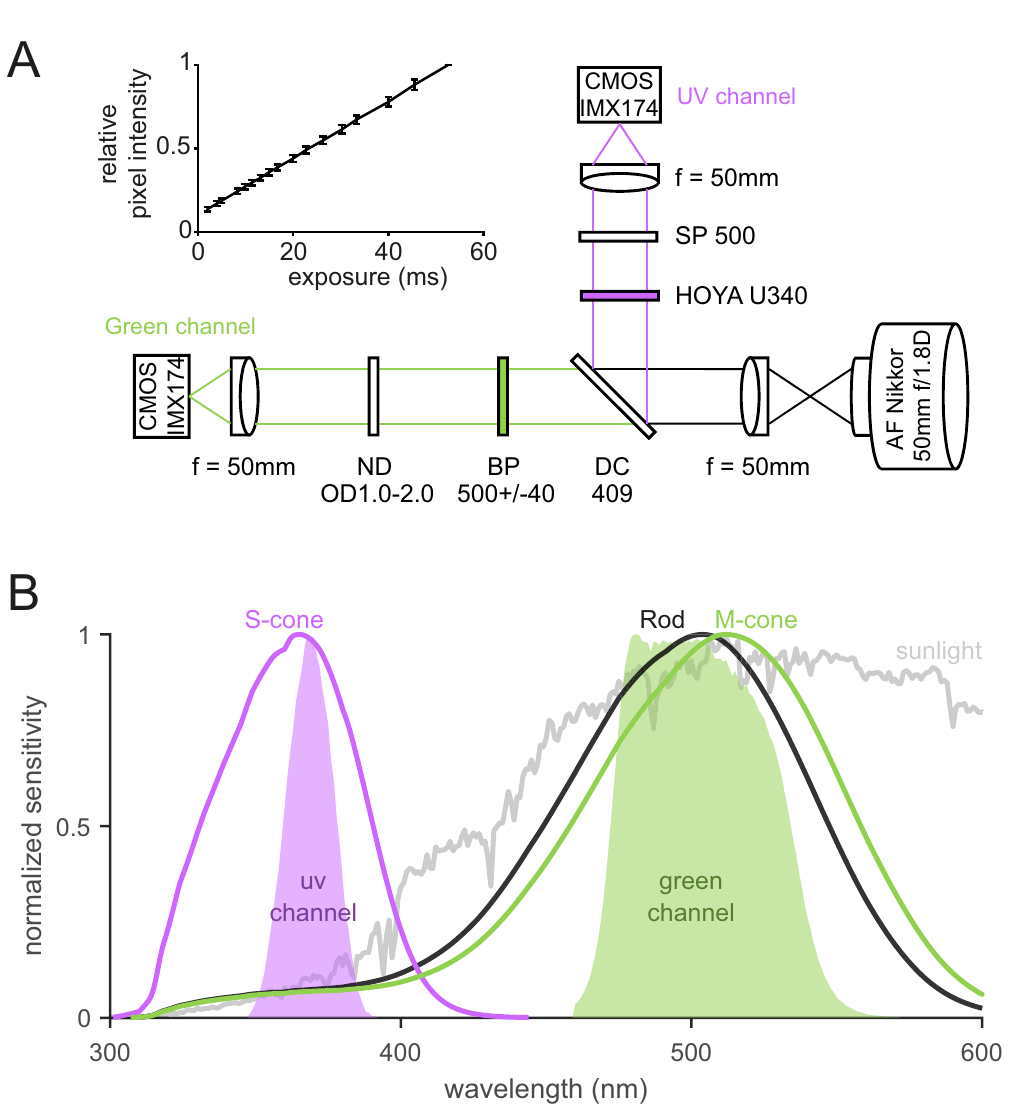
Fig 1. Multi-spectral camera system for the mouse vision. (A) Schematic diagram of the camera optics. Incoming light was split into UV and Green channels by a dichroic mirror and further filtered to match the spectral sensitivity of the mouse visual system (see panel B). A neutral density filter with the optical density value from 1.0 to 2.0 was used for the Green channel to maximize the dynamic range of the camera sensor to be used with the same parameter settings as the UV channel. The inset shows the pixel intensity values as a function of the exposure time (mean ± standard deviation; N = 2,304,000 pixels), supporting the linearity of the camera sensor (Sony, IMX174 CMOS). (B) Relative spectral sensitivity of the camera system (UV channel, violet area; Green channel, green area). For comparison, the spectral sensitivity of the mouse rod and S- and M-cone photoreceptors [31] corrected with the transmission spectrum of the mouse eye optics [30] was shown in black, violet and green lines, respectively, as well as typical sunlight spectrum in